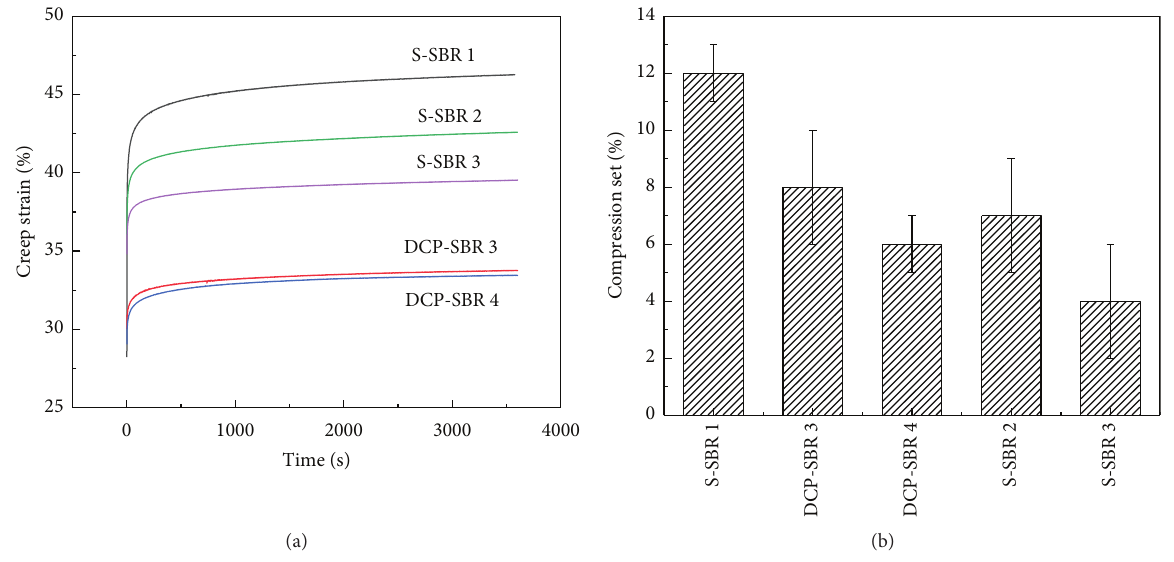
Figure 6: Creep behavior (a) and compression set (b) of five samples as a function of time under